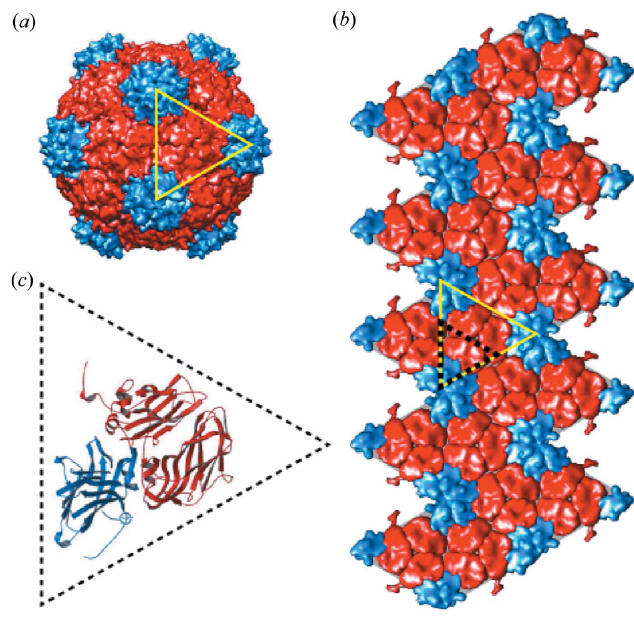
Figure 1 ( a ) 3D illustration of the icosahedral capsid of CPMV. ( b ) Flattened layout of the icosahedral capsid. The yellow triangles in ( a ) and ( b ) represent the same surface. ( c ) Two types of proteins (red and blue) that form one of the 60 units (black dashed triangle), as shown in ( b ). The figures were obtained from VIPERdb (http://viperdb.scripps.edu) (Montiel-Garcia et al. ,